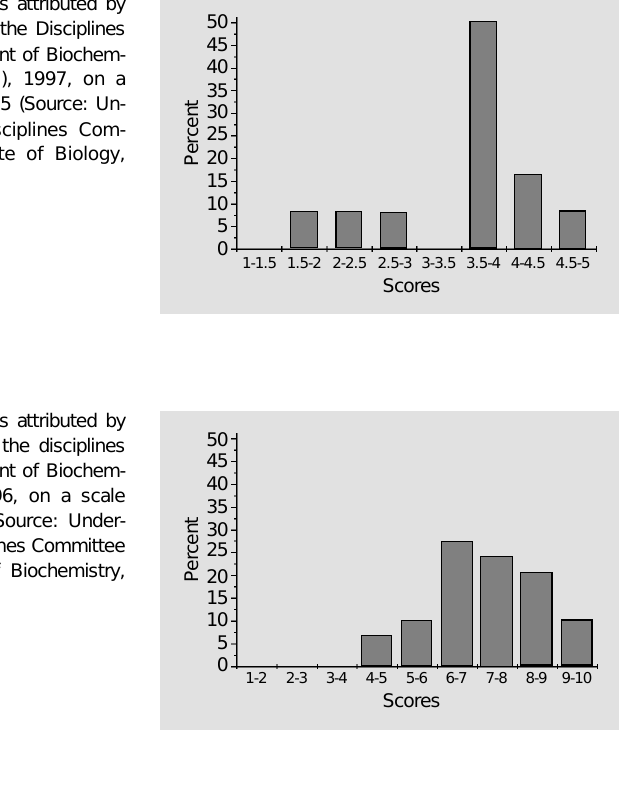
Figure 3 - Scores attributed by the students to the Disciplines of the Department of Biochem- istry (UNICAMP), 1997, on a scale from 1 to 5 (Source: Un-